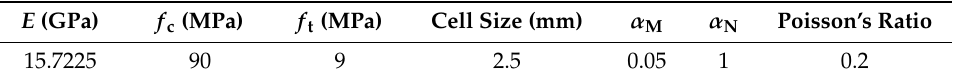
Table 3. Values of input parameters in the numerical simulation of the uniaxial compressive test.